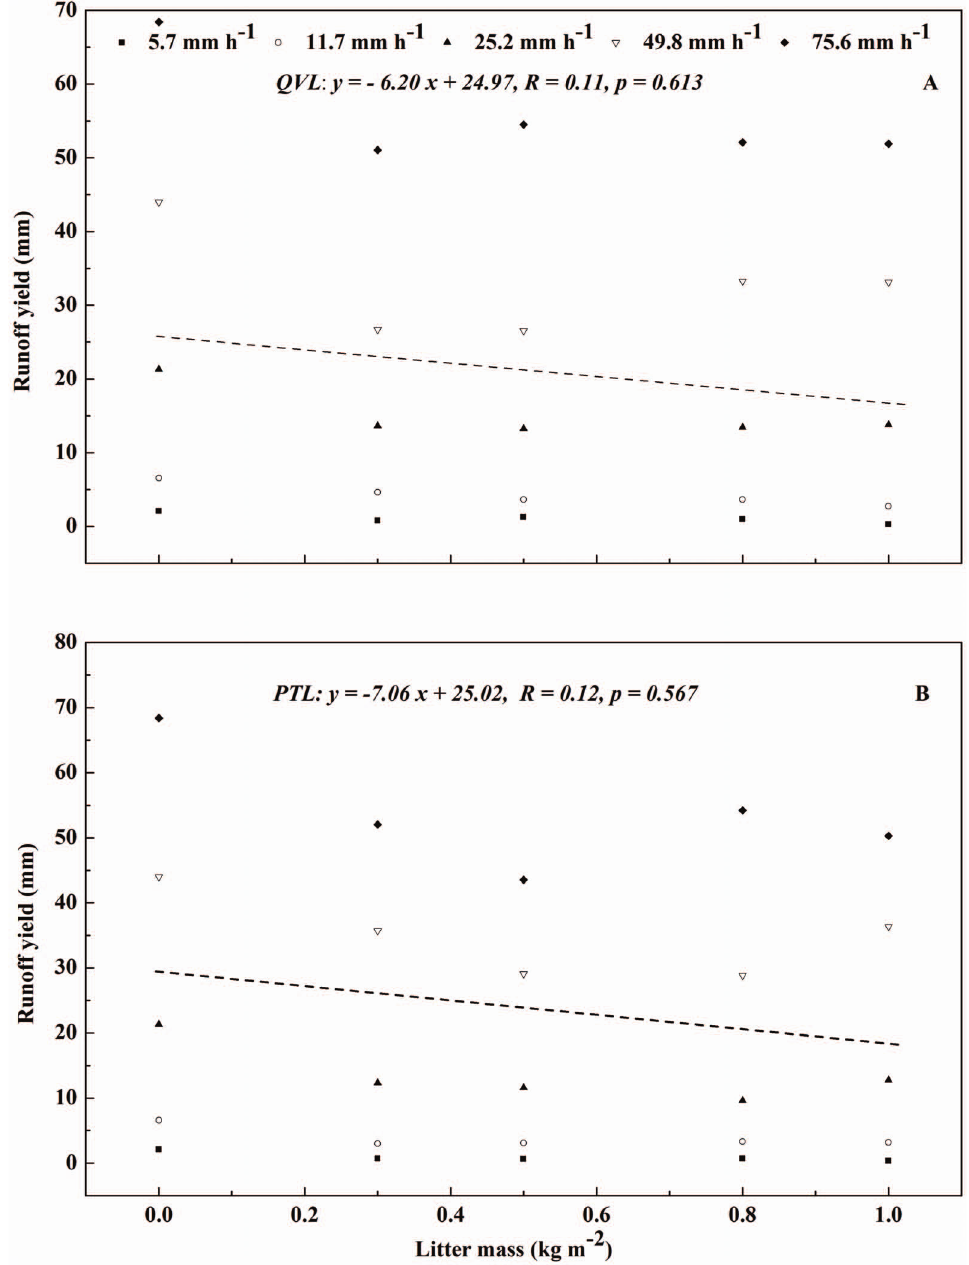
Figure 3. Runoff yield versus litter mass for five rainfall intensities for bare-soil plots (Litter mass equals zero represents ‘bare’), Quercusvariabilis litter (A), and Pinustabulaeformis litter (B).